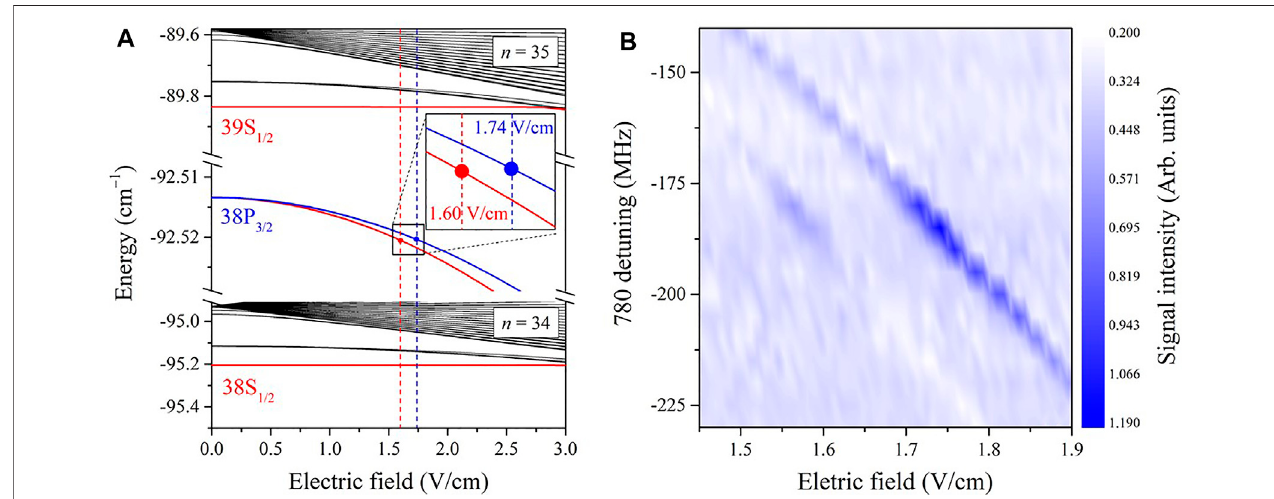
FIGURE4| (coloronline). (A) CalculationsoftheStarkmapnearn=34and35manifolds.Intheelectric fi eld,the|38P 3/2 〉 stateshiftsandsplitsintotwoStarklines, forming two Förster resonant pointsat theelectric fi eld1.60 V/cm and1.74 V/cm,respectively, asshown withtheblacksquare.Theinsetshowstheenlargementofthe squaremarked region. (B) Contourplotofthe |38S 1/2 〉 state transferred from theinitial |38P 3/2 〉 state asafunction oftheDC electric fi eld and the780-nmlaser detuning Δ 〉 state can be observed at the electric fi elds of 1.58 ± 0.01 V/cm and 1.74 ± 0.01 V/cm, respectively. 780 . The signal of the |38S 1/2